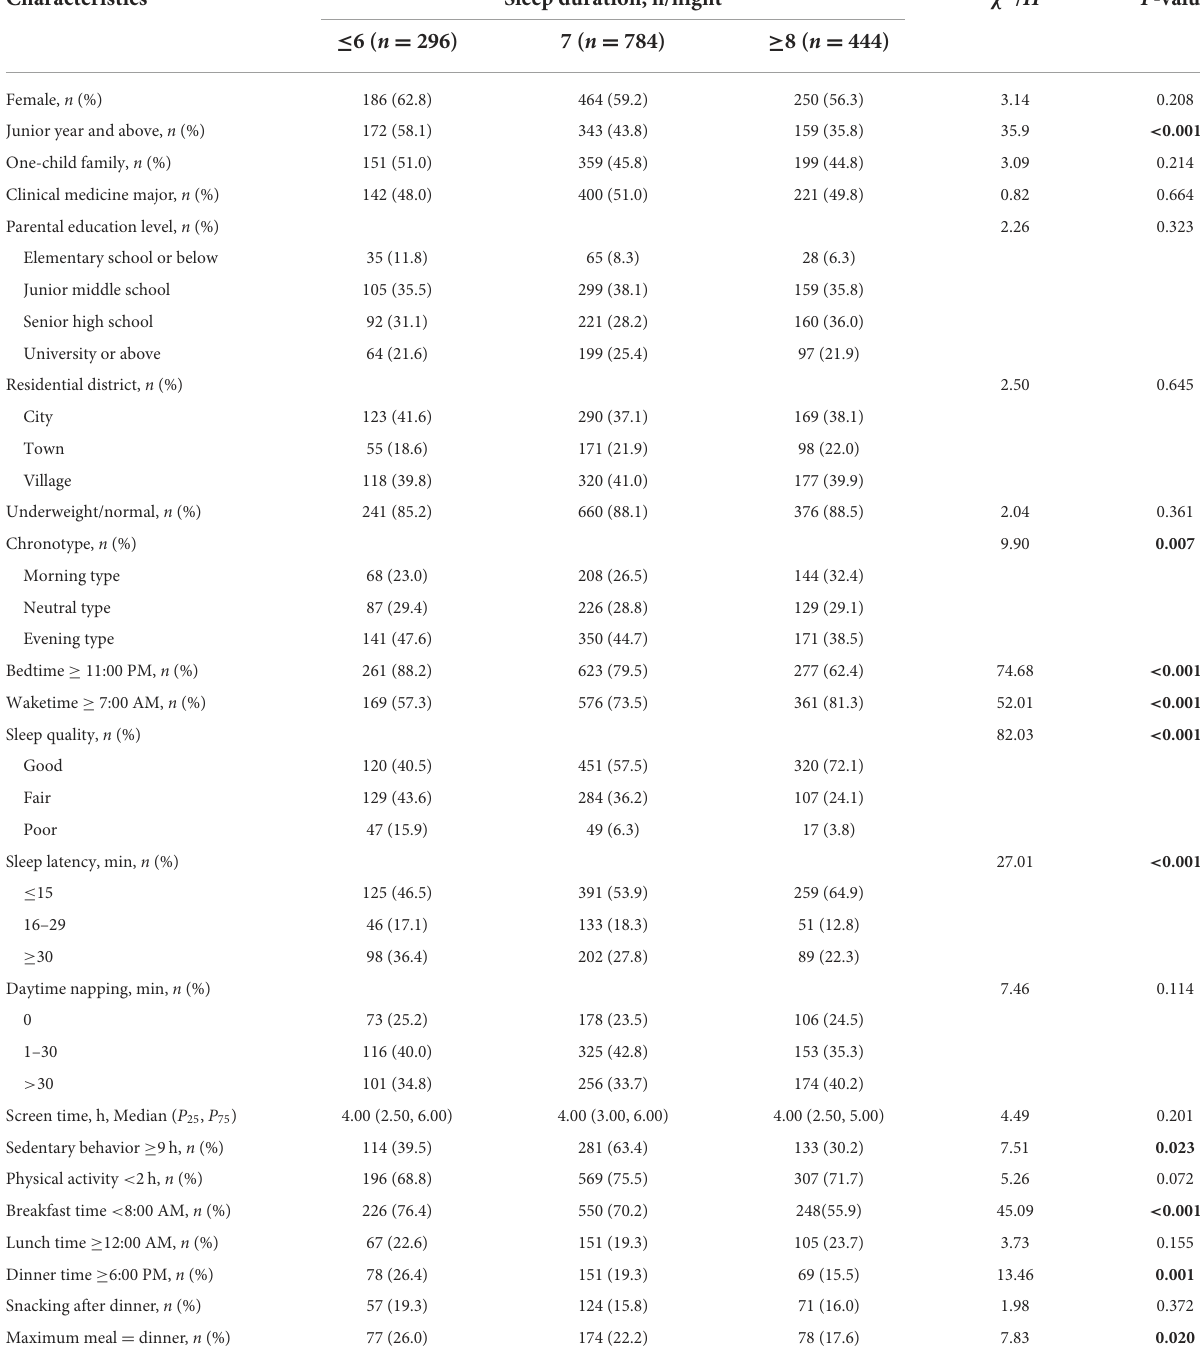
TABLE 1 Basic characteristics and biorhythmic factors of medical students by sleep duration ( n = 1524).